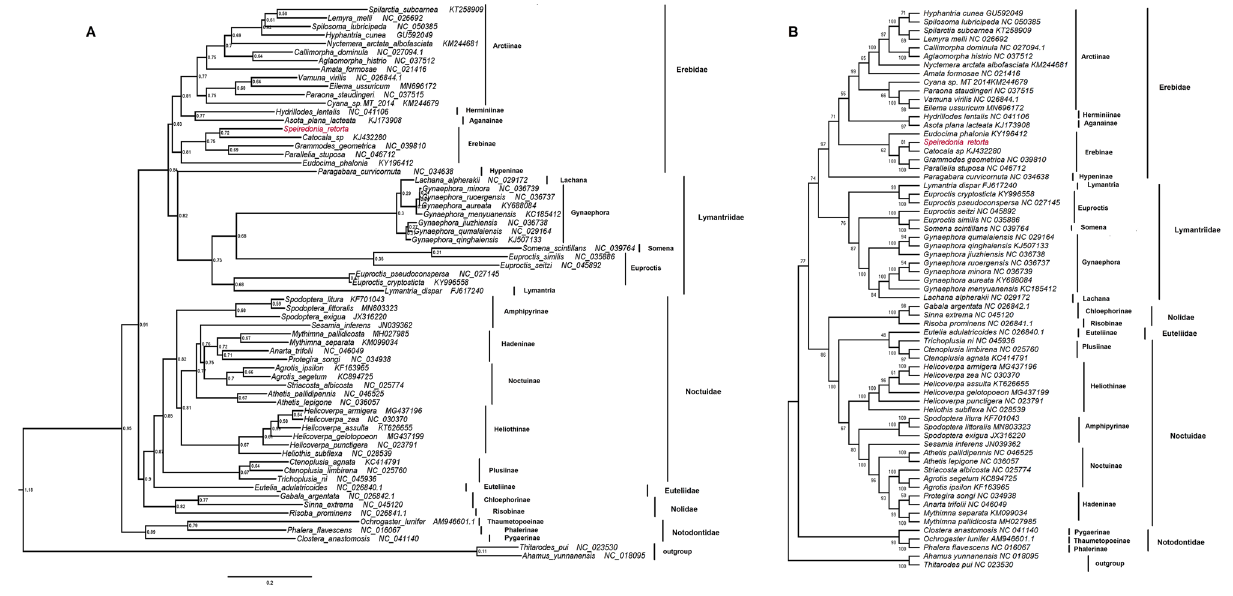
Ahamus yunnanensis (NC_018095) and Thitarodes pui